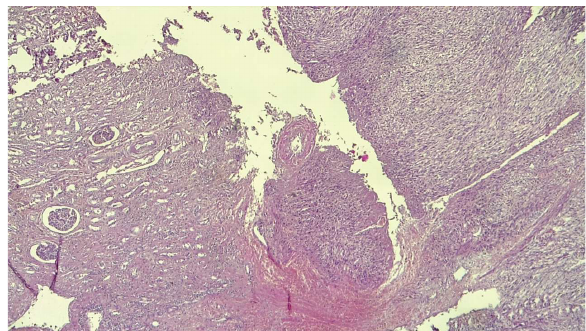
Figure 3: (HE × 40). Normal kidney (left) and fasciculated tumour proliferation (right).